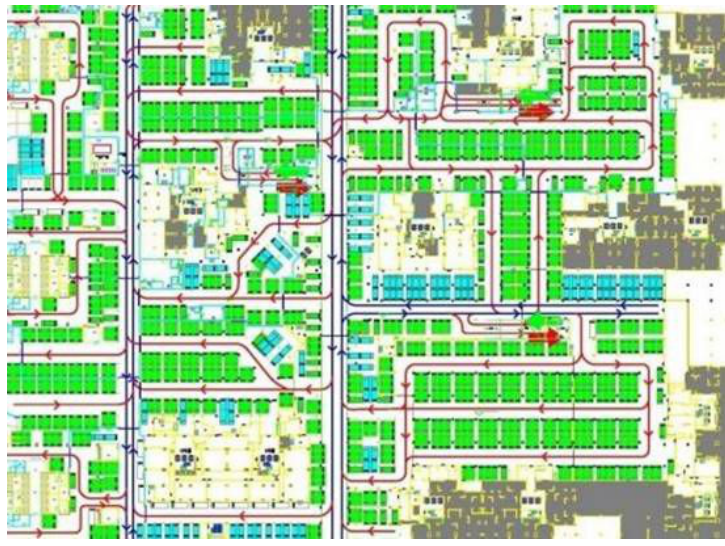
Figure 21. Parking lot of a large shopping mall. The green part is the parking